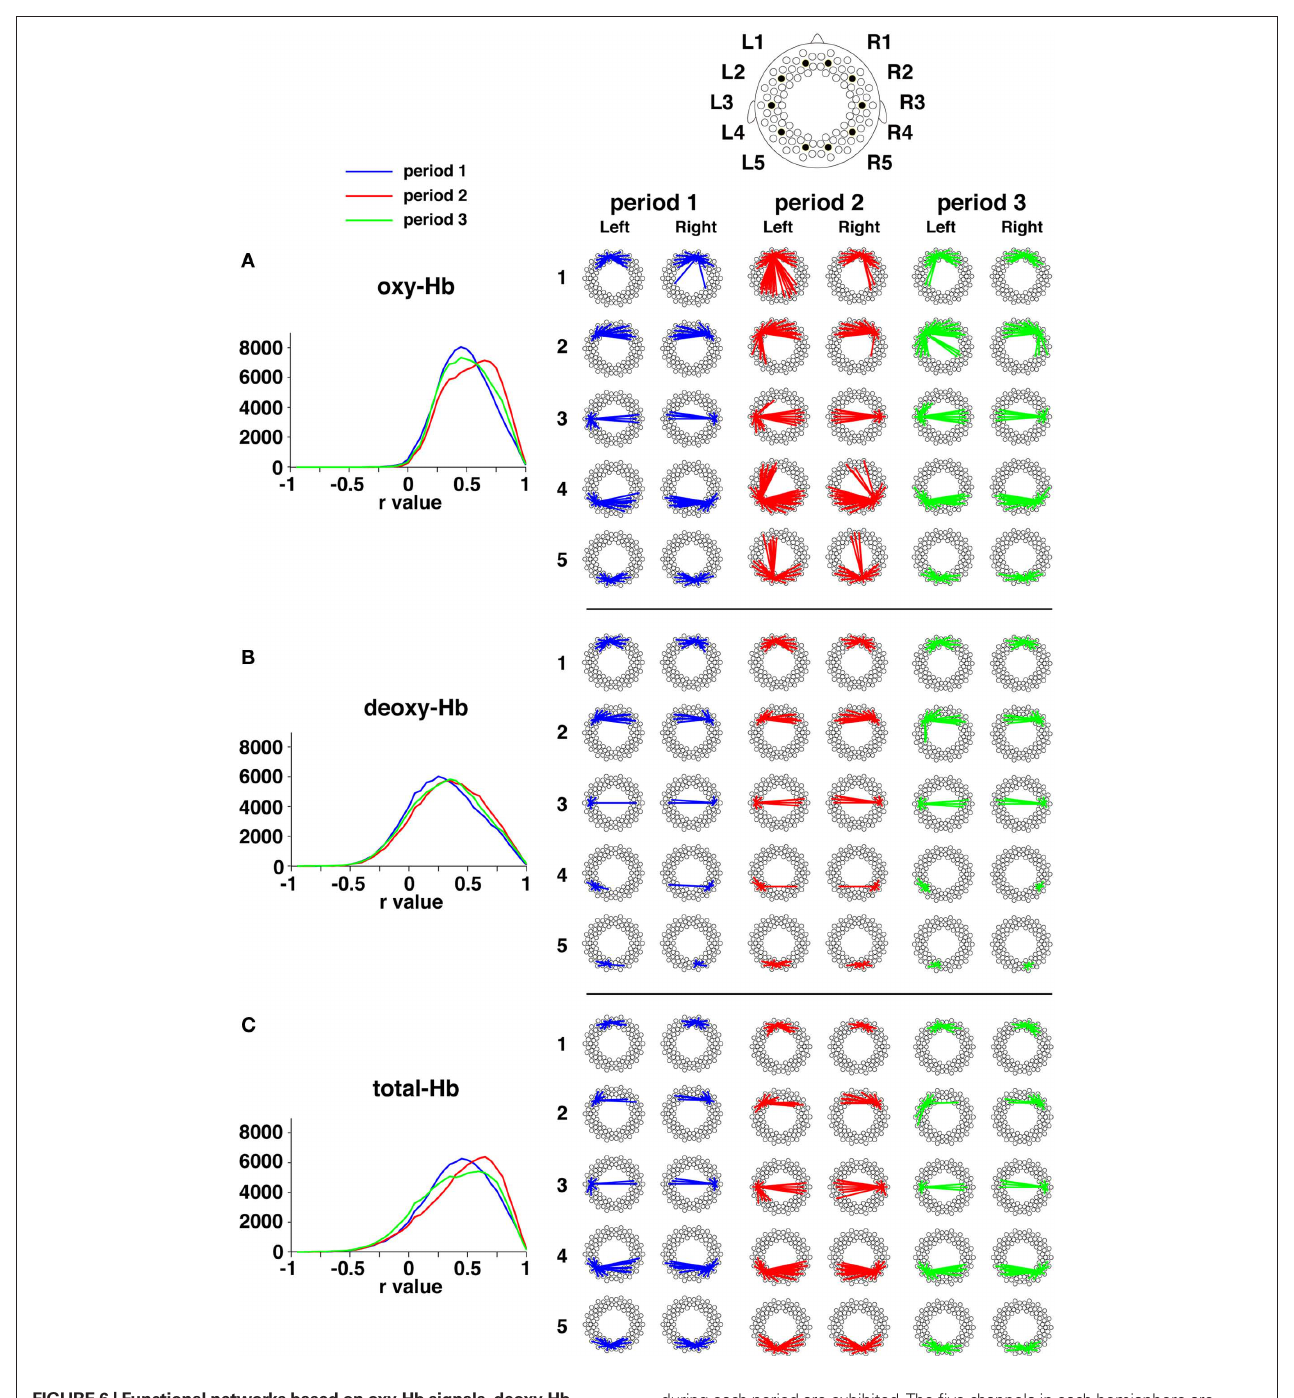
during each period are exhibited. The five channels in each hemisphere are the same as those shown in Figure 2 . The lines show correlations that are higher than 0.5 (averaged across all infants in each group). (B) Temporal correlations in deoxy-Hb signals. (C) Temporal correlations in